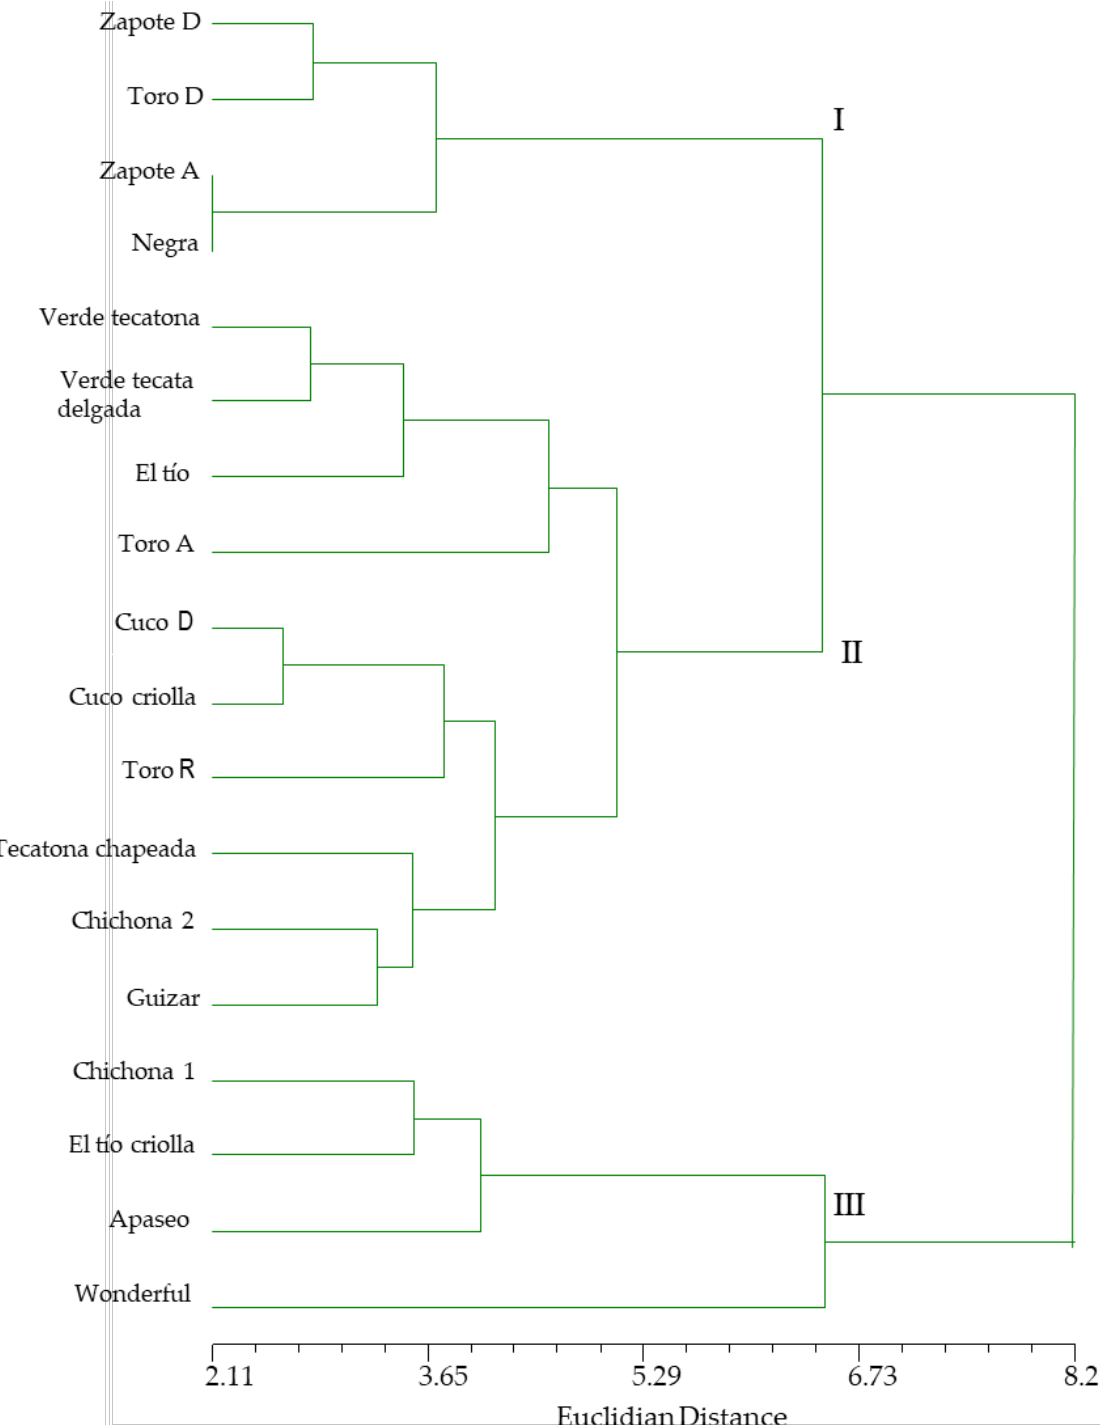
Figure 3. UPGMA dendrogram (based on Euclidean distance) of 18 pomegranate genotypes from southern Jalisco, obtained with fruit traits. I, II and III: the three main groups formed from the analysis.